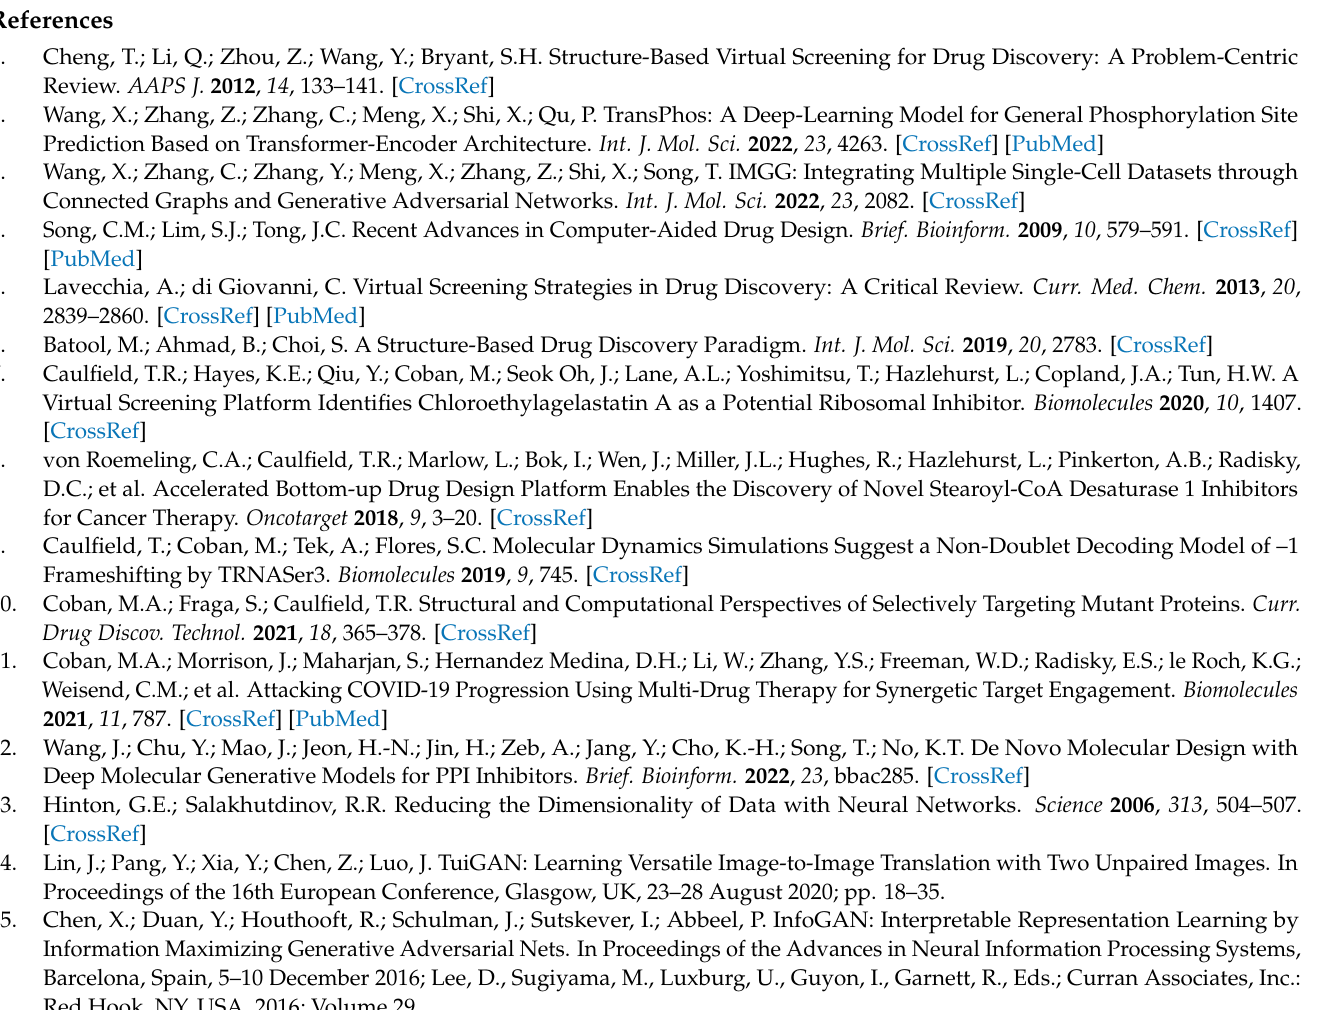
Figure A7. Distribution of the SA scores and the QED scores of the generated molecules for HTR1A.